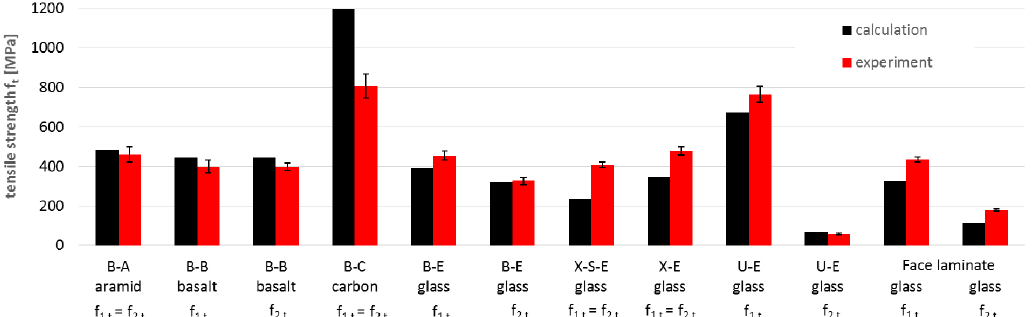
Figure 13. Comparison of tensile strength f 1,t and f 2,t obtained by calculation and experiment.